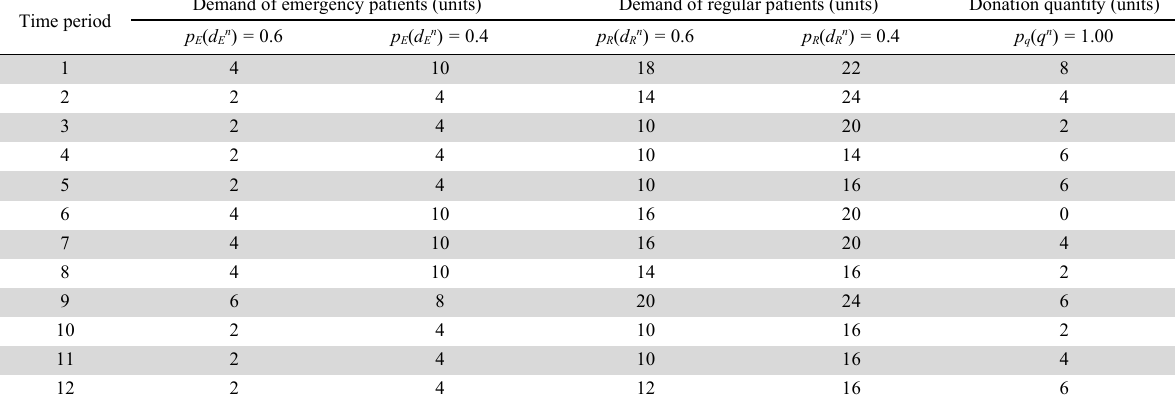
Emergency demand, regular demand, and donation quantity based on their discrete probability distributions Time period